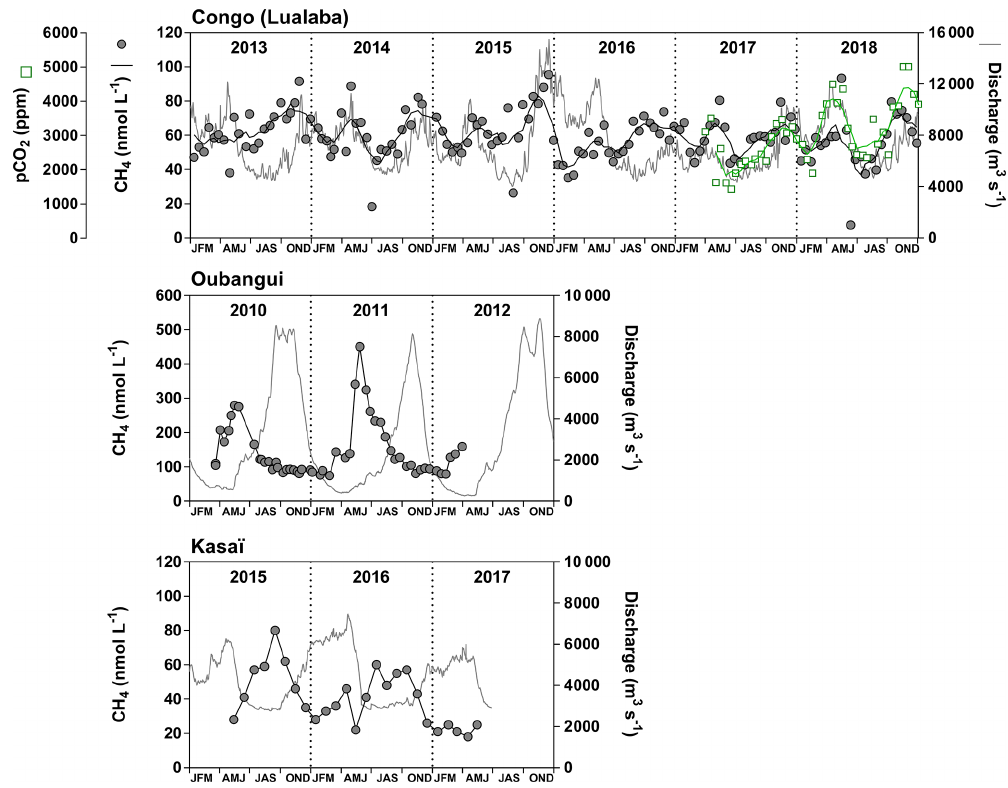
Figure 20. Time series of dissolved CH 4 concentration (nmolL − 1 ) in surface waters and freshwater discharge (grey line) in the Congo (at Kisangani, 2013–2018), the Oubangui (at Bangui, 2010–2012) and the Kasaï (at Dima, 2015–2017) rivers. The black line shows a five sample running average. Time series of the partial pressure of CO 2 ( p CO 2 in ppm) in surface waters was also obtained in the Congo River (at Kisangani, 2017–2018). Data in the Oubangui were previously reported by Bouillon et al. (2012, 2013).